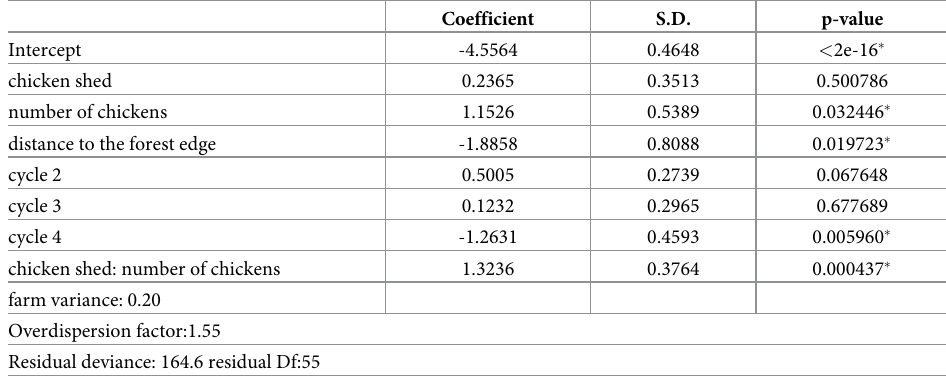
Table 4. Generalized linear mixed models of the variation of abundance in phlebotomine emergence (a) at the plot level and (b and c) at the quadrant level. The variables used in the model were environments (chicken shed and below house), number of chickens, distance to the forest edge, cycle (cycle 1, cycle 2, cycle 3, and cycle 4) and farm fac- tor, which was included as random factor. Significance: p < 0.05 � . Model: Abundance of emergent ~ environment: number of chickens + distance to the forest edge + cycle + random effect